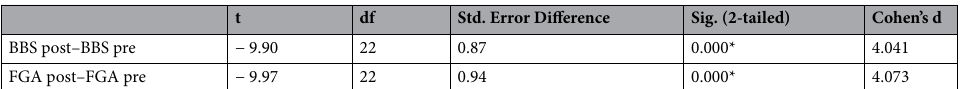
Table 3. Between-group comparison results for both variables. BBS: Berg Balance Scale; FGA: functional gait assessment. *Significant.